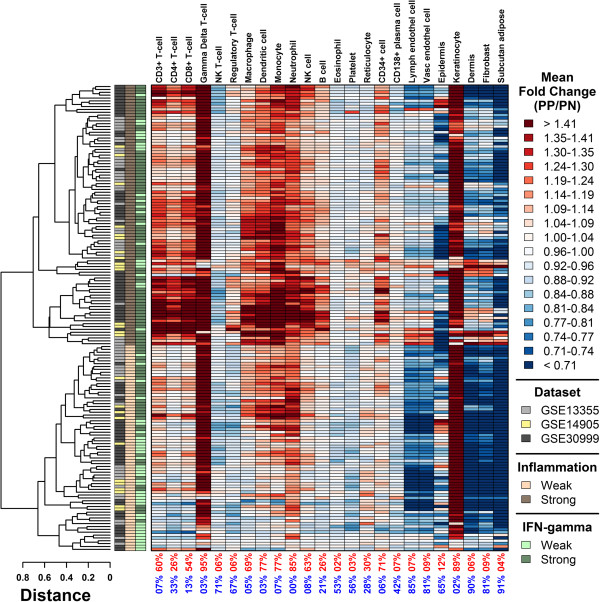
Psoriasis lesions from 163 patients can be divided into two subgroups based upon inflammatory gene expression patterns (strong inflammation: 91/163; weak inflammation: 72/163). For each cell population, we identified 250 “signature genes” most specifically expressed in that cell population relative to all other cell types. For each patient, a signature score was calculated as the weighted average of fold-changes (PP/PN) among these 250 signature genes (weighted arithmetic mean). Weighted averages were calculated by assigning greatest weight to the top-ranked gene most specifically expressed in a given cell type, with weights declining between the top-ranked and 250th-ranked gene. Values in the bottom margin indicate the proportion of patients with significantly large (red) or small (blue) signature scores (P < 0.05). Significance was evaluated by comparing fold-changes (PP/PN) of the 250 signature genes to those of all other genes represented on the array (Wilcoxon rank sum test). Patients were clustered according to signature scores using complete linkage and the Euclidean distance metric. Group assignments were made based upon whether a patient’s scores approximated a strong or weak pattern of inflammation (see legend).